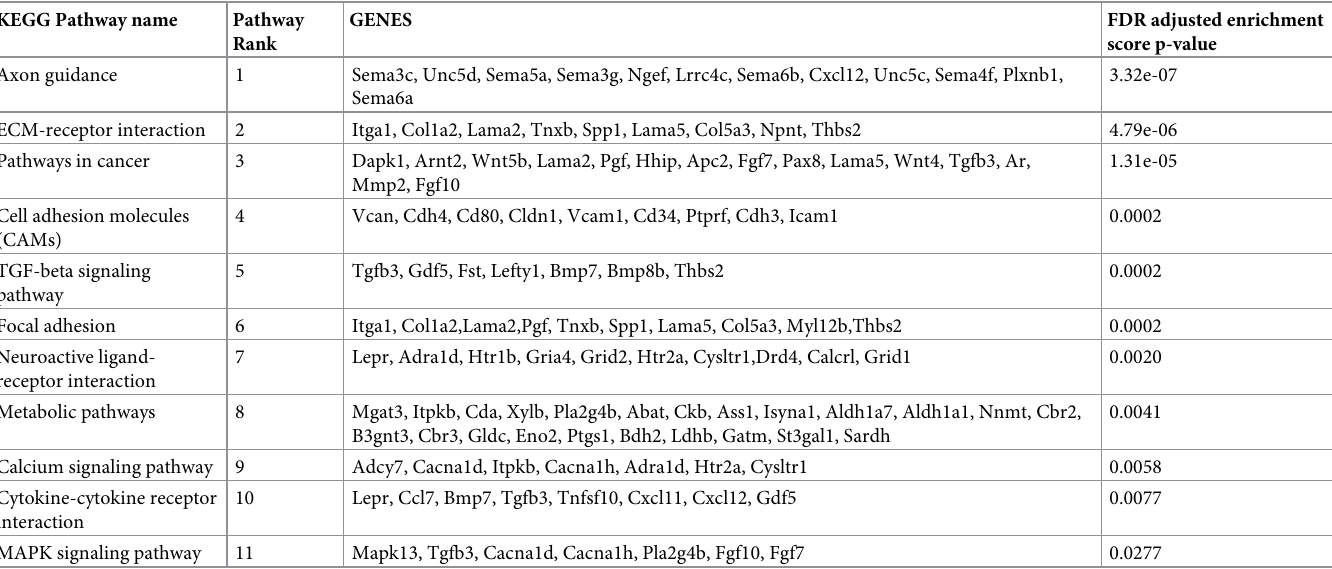
Table 2. Pathway enrichment analysis of significantly changed